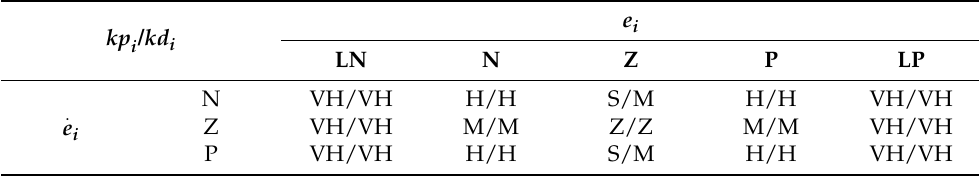
Table 2. Fuzzy control rules for kp i and kd i